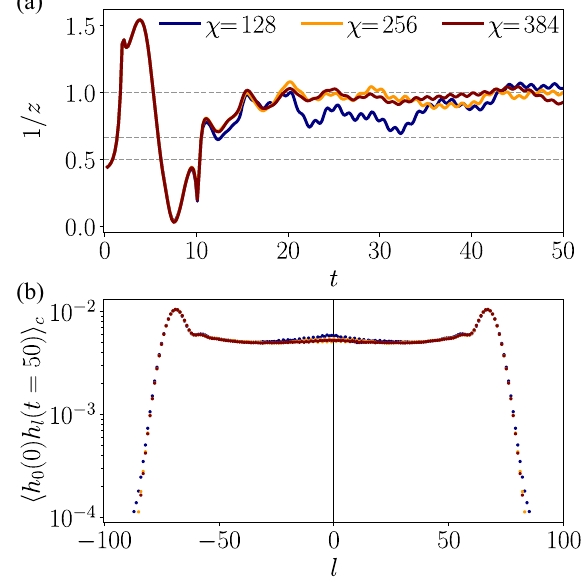
FIG. 3. (a) Instantaneous transport exponent for the integrable PNPNP deformation of the PXP model in Eq. (8). (b) Spatial dependence of the energy autocorrelation function. The profile is distinctly flat, as often seen in integrable models [59]. The data were obtained with a system of N ¼ 512